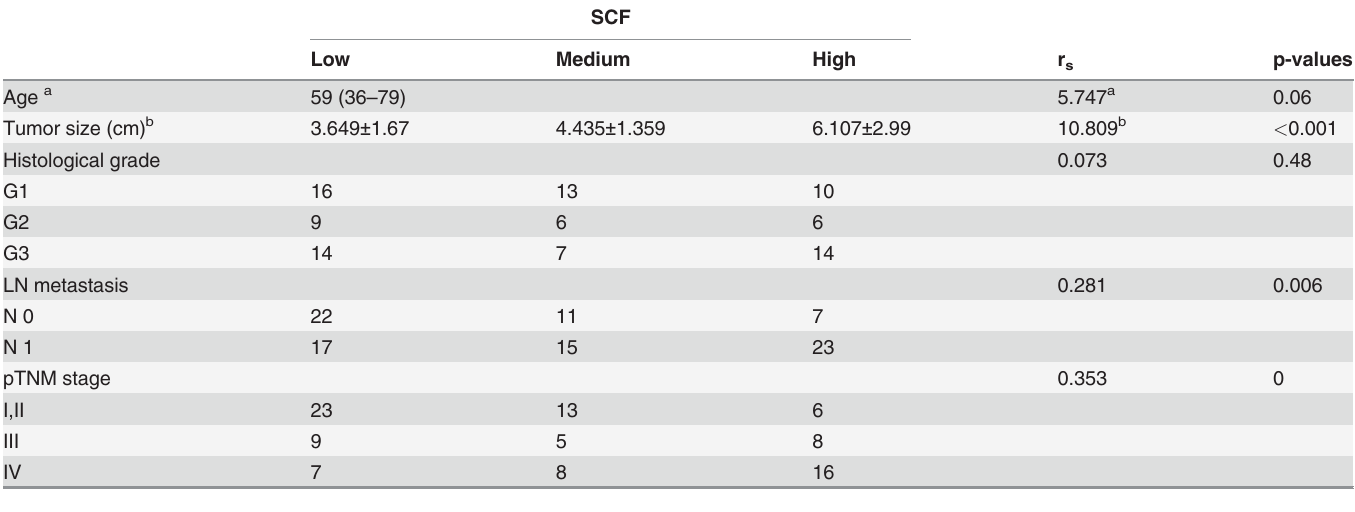
* p-values were calculated by Spearman's Rank-Correlation test (n =